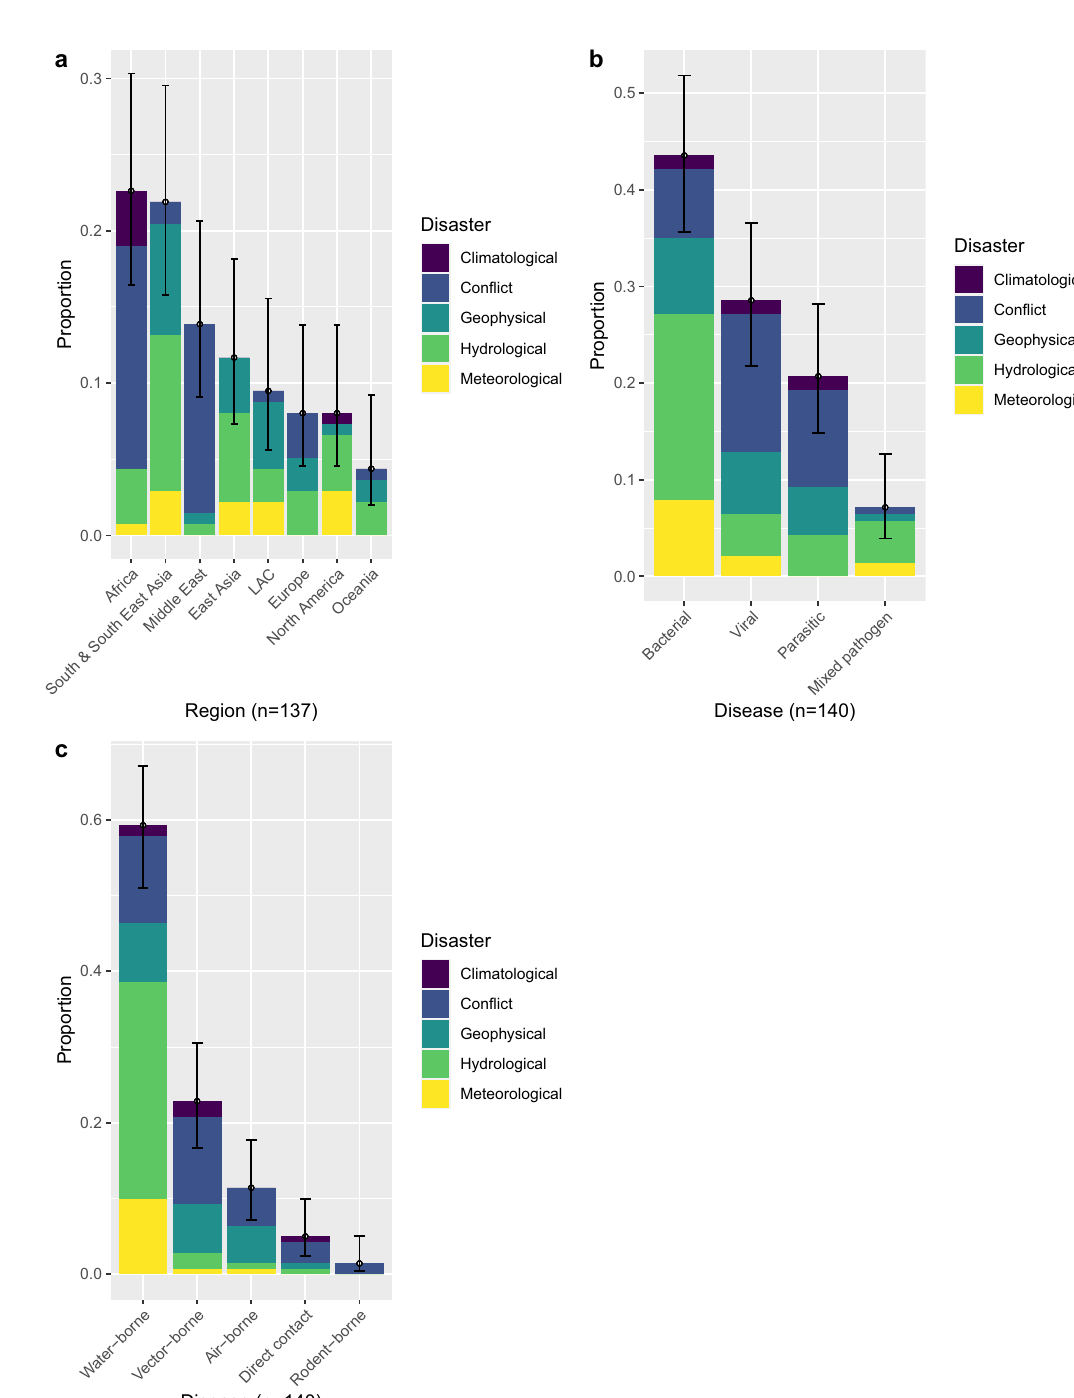
Figure 3. Proportion of reported post-disaster outbreaks by ( a ), region against the 137 separate disasters, ( b ), the 140 separate disease outbreaks by pathogen type against disaster and ( c ), the 140 separate disease outbreaks by transmission against disaster with binomial confidence intervals (95%). LAC – Latin America and the